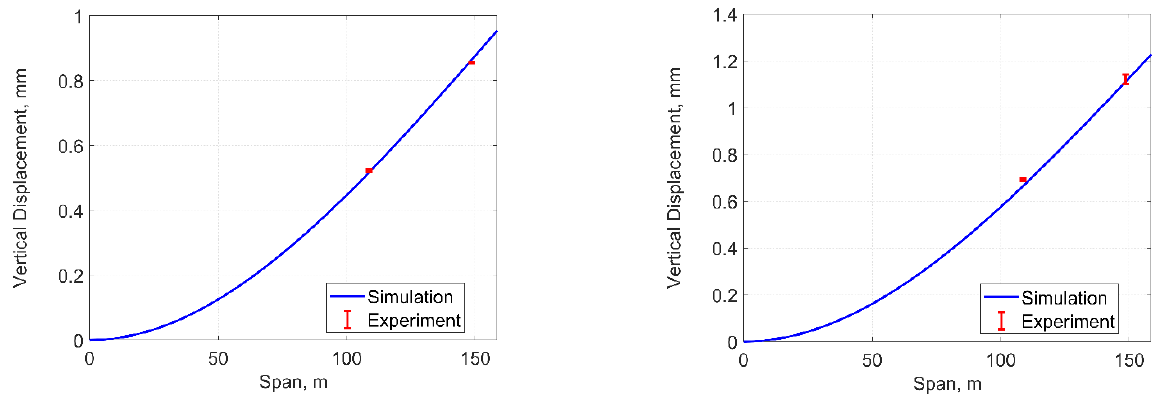
Figure 10. Vertical displacements along the span from the experiment and simulation under the tip load of 0.7 N ( left ) and 0.9 N ( right ). Table 6. Lower natural frequencies of the flutter wing with respect to bending and torsional modes.